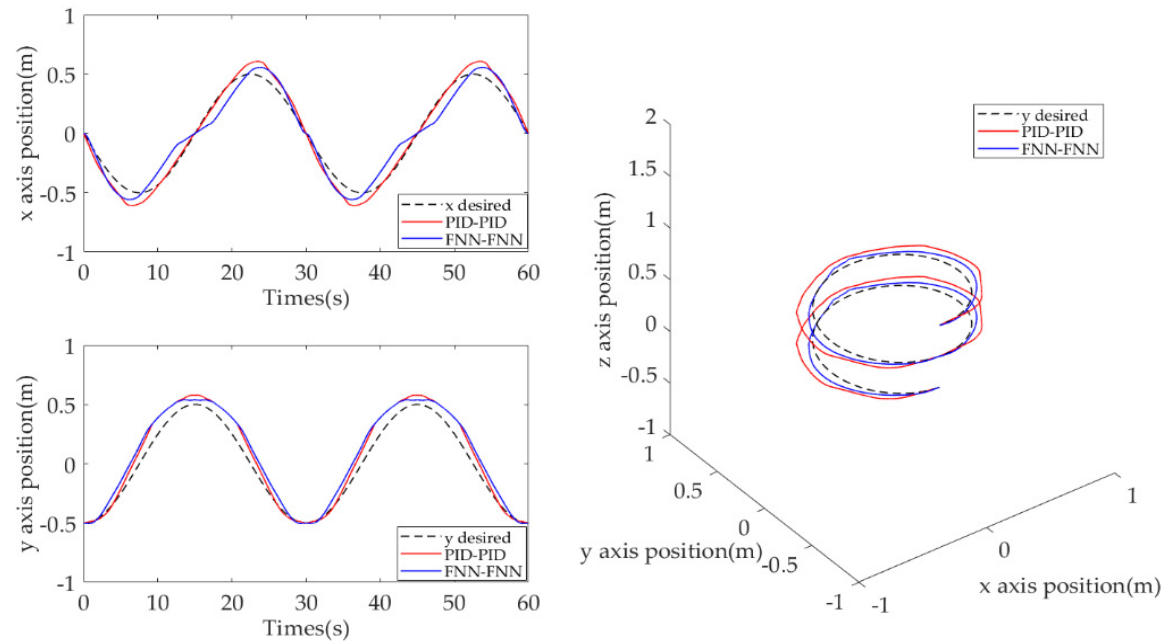
Figure 12. Experiment results of spiral trajectory tracking.